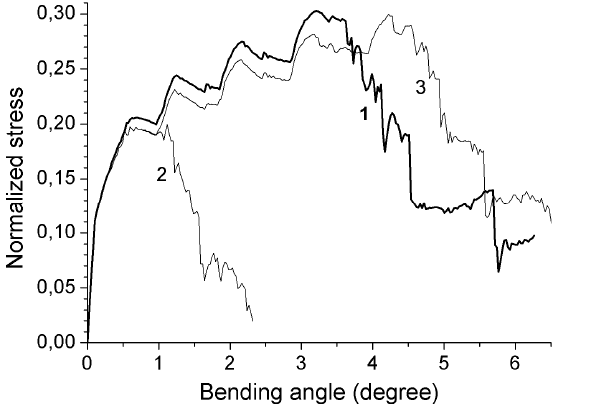
Figure 16: The load-displacement diagrams for three-point bending test of model samples of metal-ceramic composite with “wide” (curve 1) and “narrow” (curves 2 and 3) interphase boundaries ( V = 0.4 m/s). Curves 2 and 3 correspond to composites with load  ) of “narrow” interfaces: 1.0 NiCr  (2); 2.0 NiCr  (3). different values of strength ( bound t t t